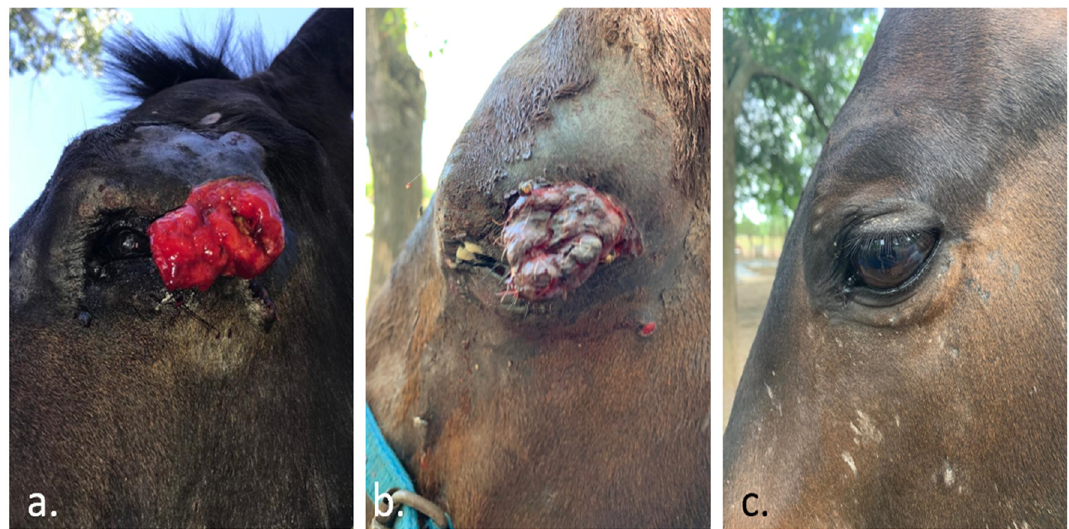
Figure 3. In this case, a horse with a sarcoid in the eyelid. In ( a ), the day the ECT was performed. In ( b ), thirty days after the ECT, the tumor experiences an increase in its size due to swelling. In ( c ), after a single session of ECT, a complete response was obtained. The animal remained disease-free for 400 days, and up to the date of the writing of this work (data not published).